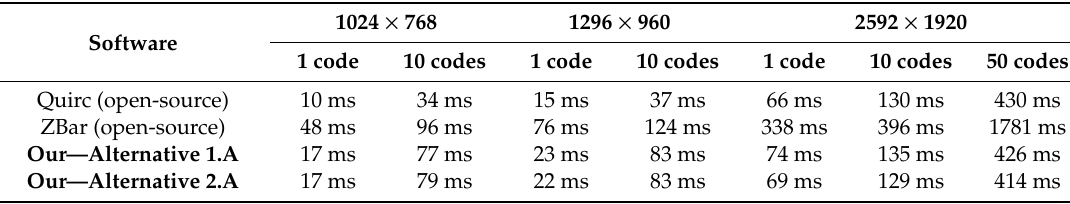
Table 2. Approximate time consumption of tested